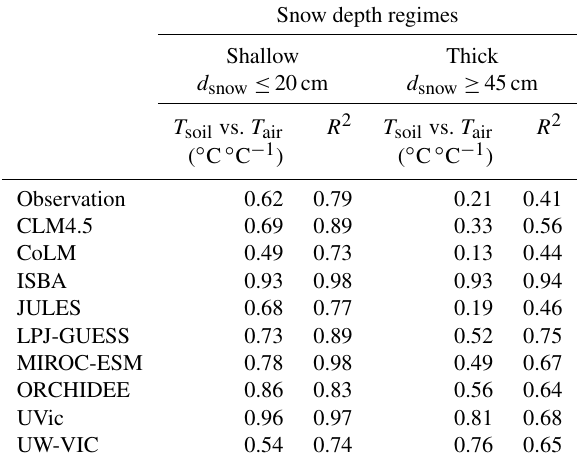
Table 2. Sensitivity of near-surface soil temperature ( T soil ) to air temperature ( T air ) in winter (DJF) calculated by the slopes of the linear regression between T soil ( ◦ C) and T air ( ◦ C) for different regimes of snow depth ( d snow ) , using data from all Russian station grid points and 21 individual winter 1980–2000. All relationships are statistically significant at p ≤